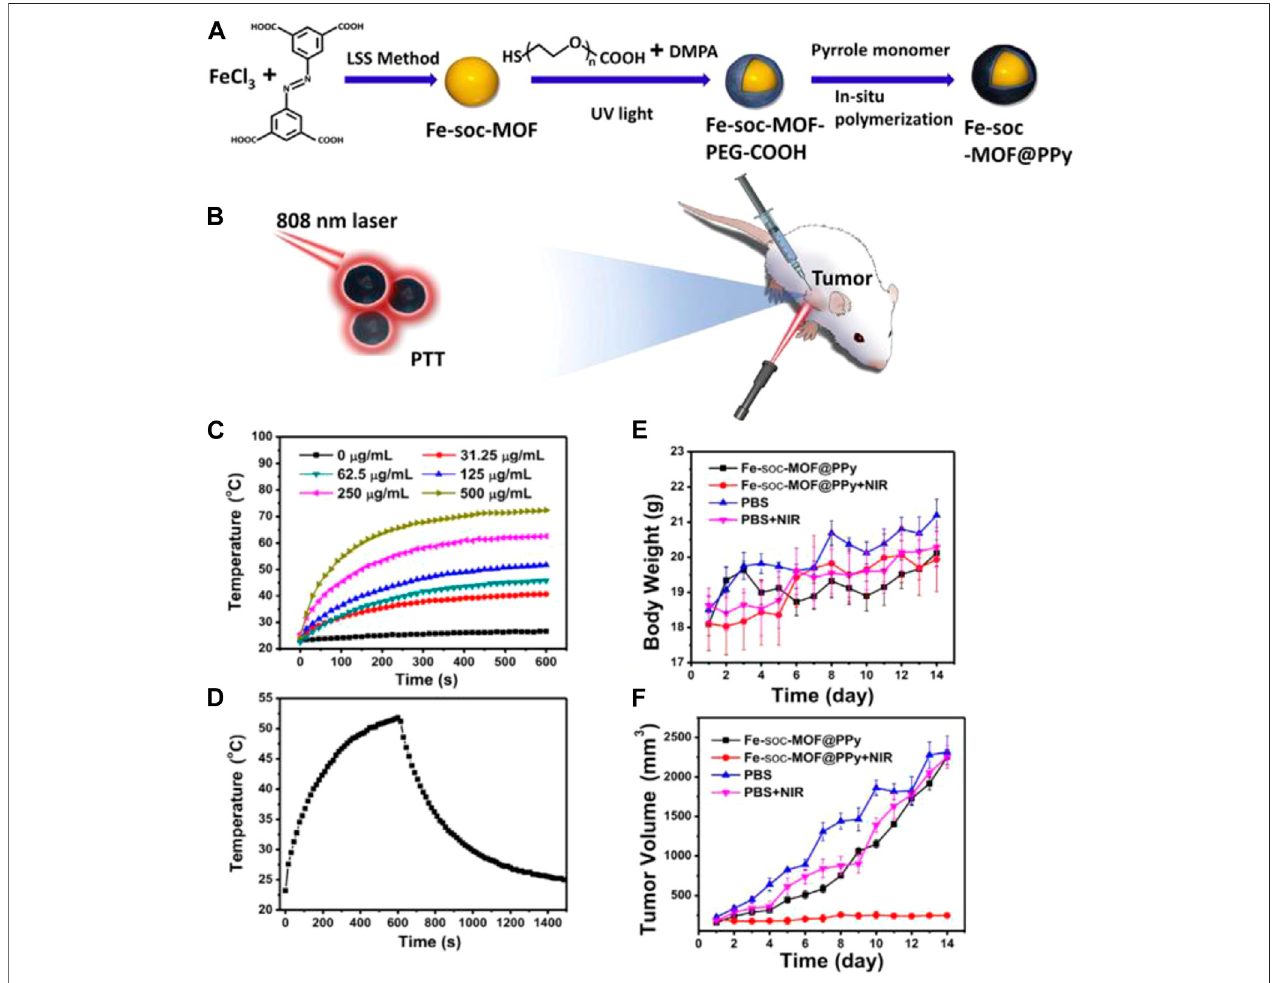
FIGURE 7 | (A) Schematic diagram of Fe-soc-MOF@PPy composite material synthesis; (B) 808 nm Laser for PTT. (C) Different concentration of Fe-soc- MOF@PPy heating curve. (D) Fe-soc-MOF@PPy heating and cooling curve. (E) The body weight change curve of mice after different treatments. (F) Tumor volume change curve after different treatments in mice, respectively. Reproduced with permission (Xuechao et al., 2019). Copyright 2019, Chemical Engineering Journal.